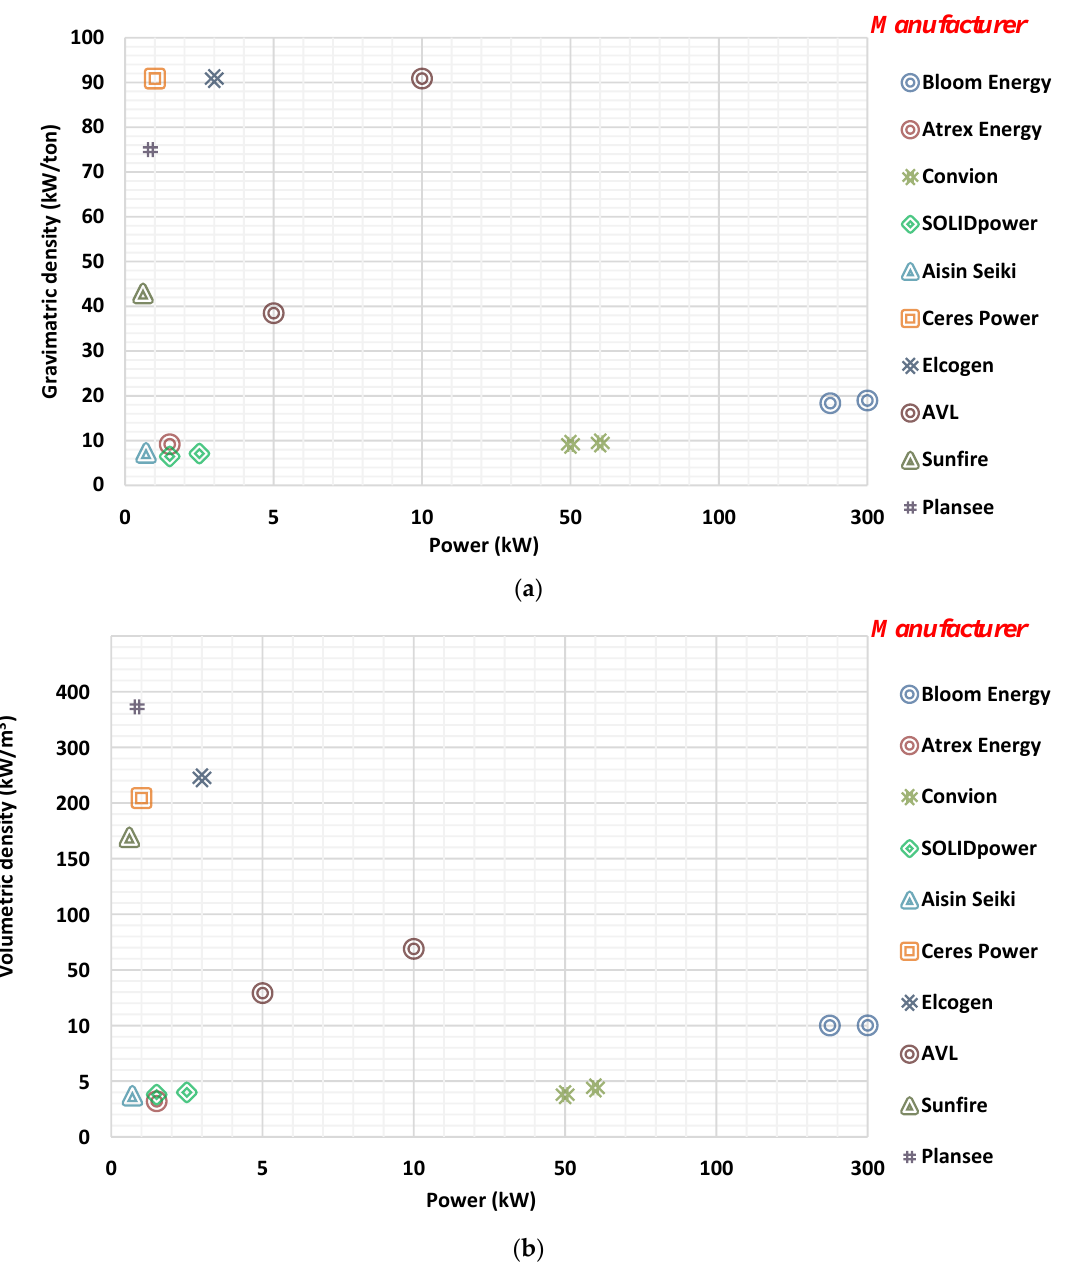
Figure 5. SOFC products ( a ) Gravimetric power density ( b ) Volumetric power density.